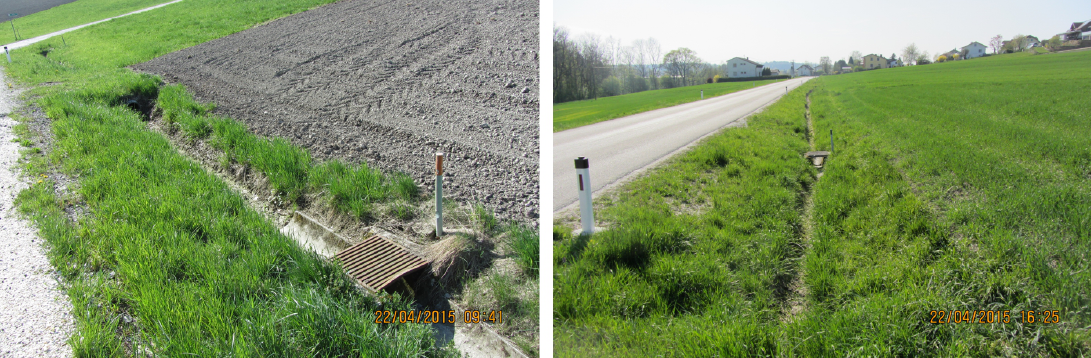
Figure 3. Roadside ditch with multiple storm drains at varying distances. The left picture was taken upstream of the